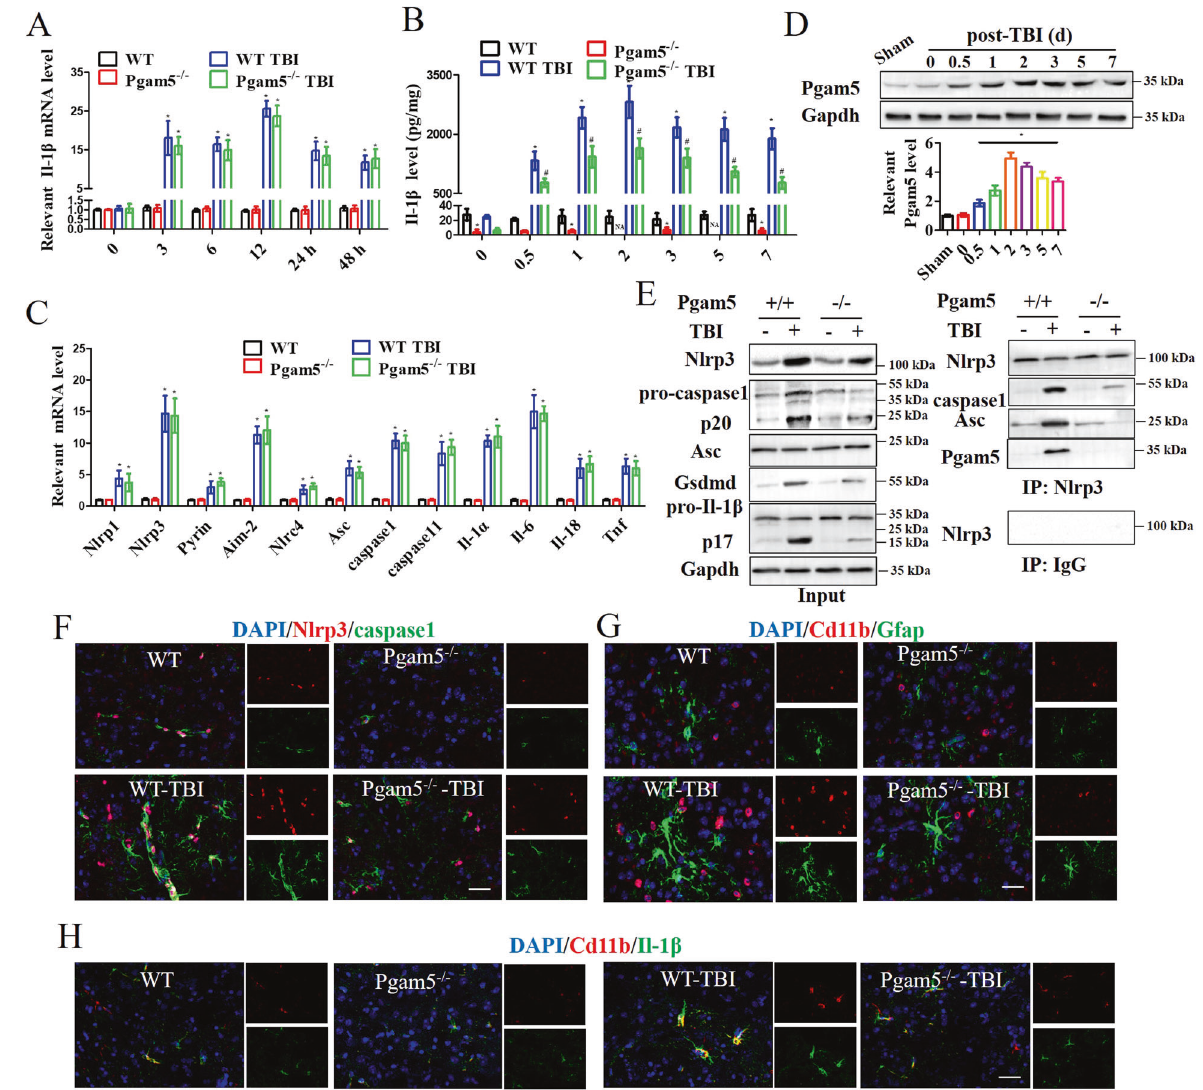
Fig. 3 Pgam5 depletion relieves TBI-induced Il-1 β through Nlrp3 in fl ammasome activation and Pgam5 is involved in TBI-induced microglial activation in vivo. The Il-1 β level was monitored after TBI in WT and Pgam5 − / − mice. A qRT-PCR analysis of Il-1 β mRNA level and ( B ) ELISA analysis of Il-1 β level. C Nlrp1, Nlrp3, Pyrin, Aim-2, Nlrc4, Asc, caspase1, caspase11, Il-1 α , Il-6, Il-18, and Tnf mRNA in Pgam5 − / − -TBI mice were measured at 24 h after TBI. ( A , B and C ) * p < 0.001 compared to the WT group and # p < 0.001 compared to the WT TBI group by two-way ANOVA followed by Tukey ’ s post hoc multiple comparison test. D Western blot analysis of Pgam5 expression during 7 days after TBI in the cortex. The lysate of the cortex was analyzed using Western blot assay to detect the Nlrp3/caspase1/Il-1 β pathway at 48 h after TBI. * p < 0.001 compared to the sham group by one-way ANOVA followed by Tukey ’ s post hoc multiple comparison test. E Results of immunoblotting with antibodies to the indicated proteins and immunoprecipitated with anti-Nlrp3. At 48 h after TBI in WT and Pgam5 − / − mice, cortical sections were analyzed by immuno fl uorescence for the expression of ( F ) Nlrp3/ caspase1, ( G ) Cd11b/Gfap, and ( H ) Cd11b/Il-1 β . Nuclei were stained with DAPI. Scale bar: 20 μ m. Data shown are means ± SEM, n =